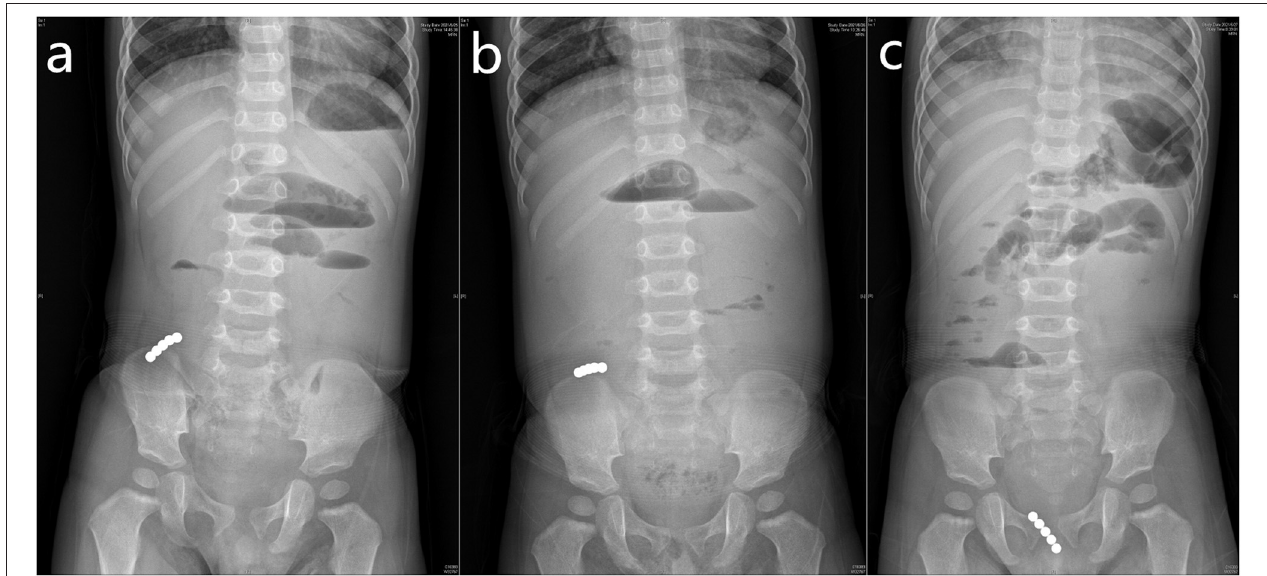
FIGURE 1 | Plain abdominal and pelvic radiographic imaging revealed the progression of the Buckyballs. The Buckyballs passed spontaneously on 5 post-ingestion days and partial small bowel obstruction